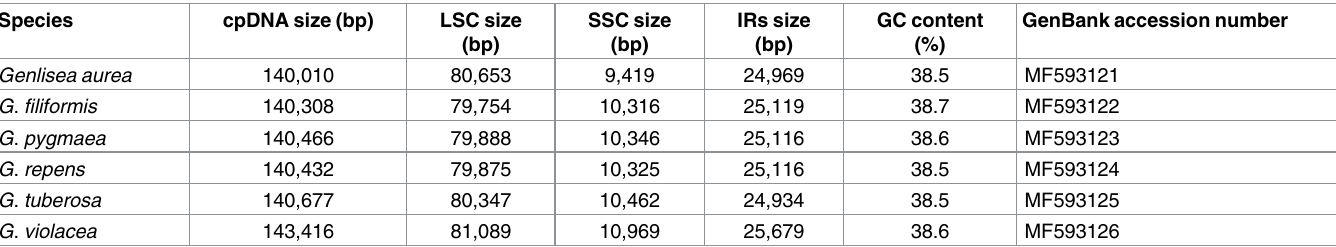
Table 1. Summaryof assembly data for Genlisea plastomes (for details about sequencing data see S1 Table). Species cpDNA size